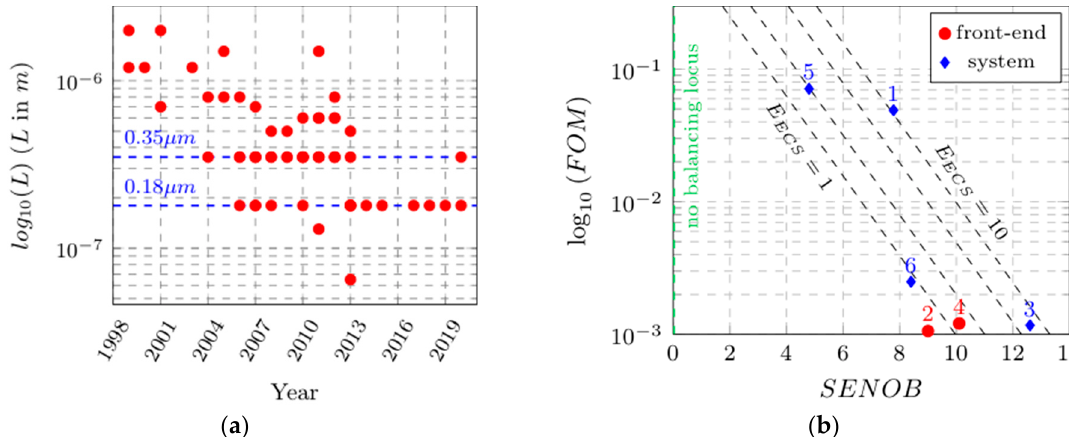
Figure 2. ( a ) Technological evolution (minimal technologic gate length) of stimulator circuits between 1998 and 2019. ( b ) FOM evaluation versus tissue safety criterion [32] of current trends in stimulation.( ♯ 1: [33], ♯ 2: [34], ♯ 3: [35], ♯ 4: [36], ♯ 5: [37], ♯ 6: [38]).